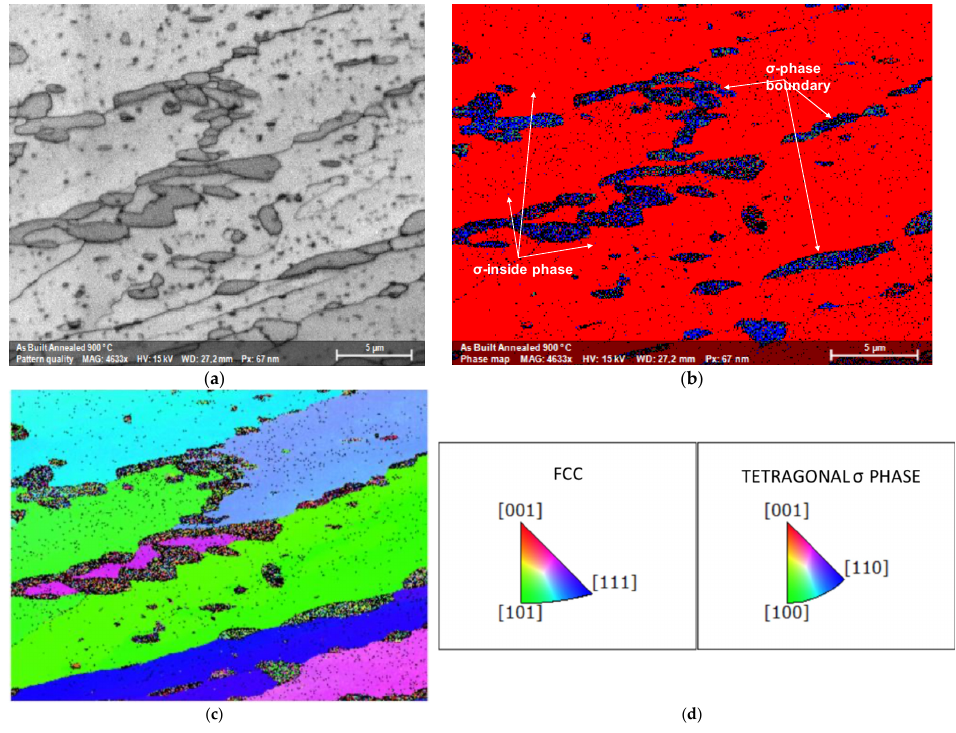
Figure 13. ( a ) Cross-sectional image of an as-built sample annealed at 1173 K for 100 h; ( b ) corresponding EBSD map, with FCC matrix in red and σ phase precipitates in blue. ( c ) Inverse pole figure along Y direction, IPFY, of the same sample. ( d ) IPFY color scheme.